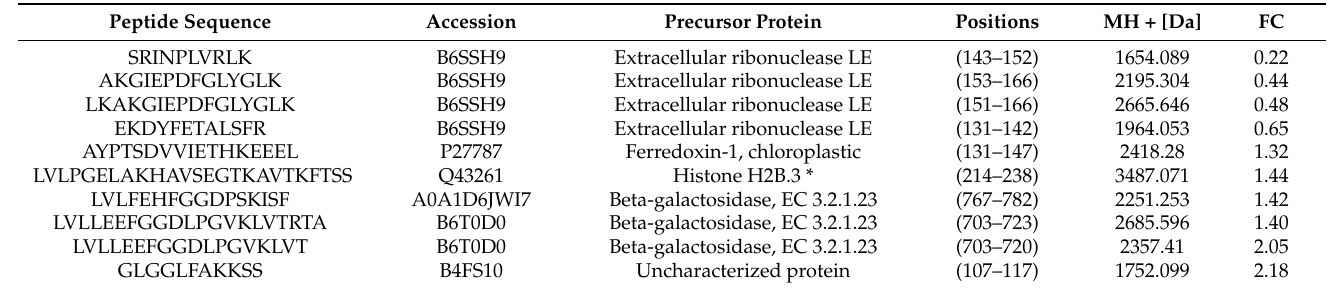
Table 2. Ten common DEPs found in maize leaves on day 1 after infection with Bipolaris maydis .